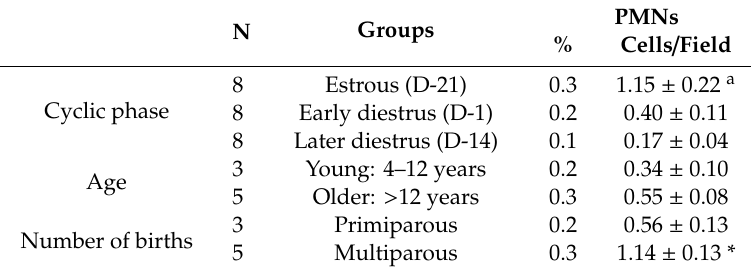
Table 3. Neutrophil count (Mean ± SD) in jennies.